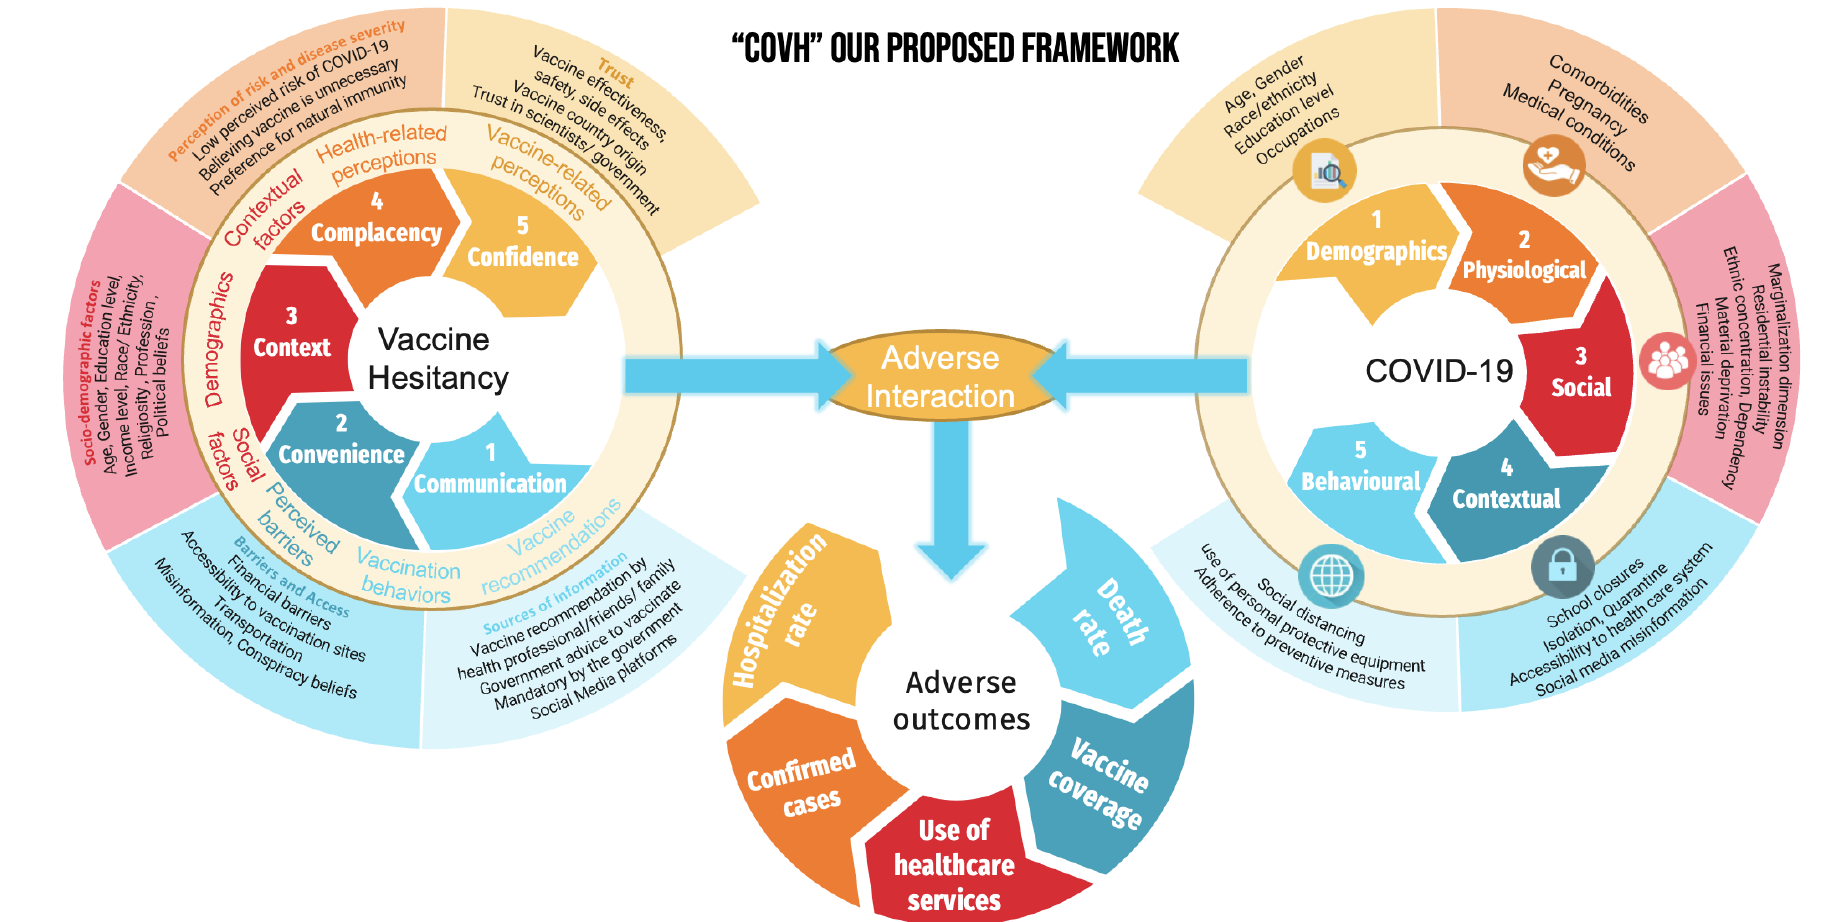
Figure 1. COVID-19 and vaccine hesitancy syndemic framework “COVH” 3.3.1. Components of “COVH” syndemic f raming “COVH” syndemic.